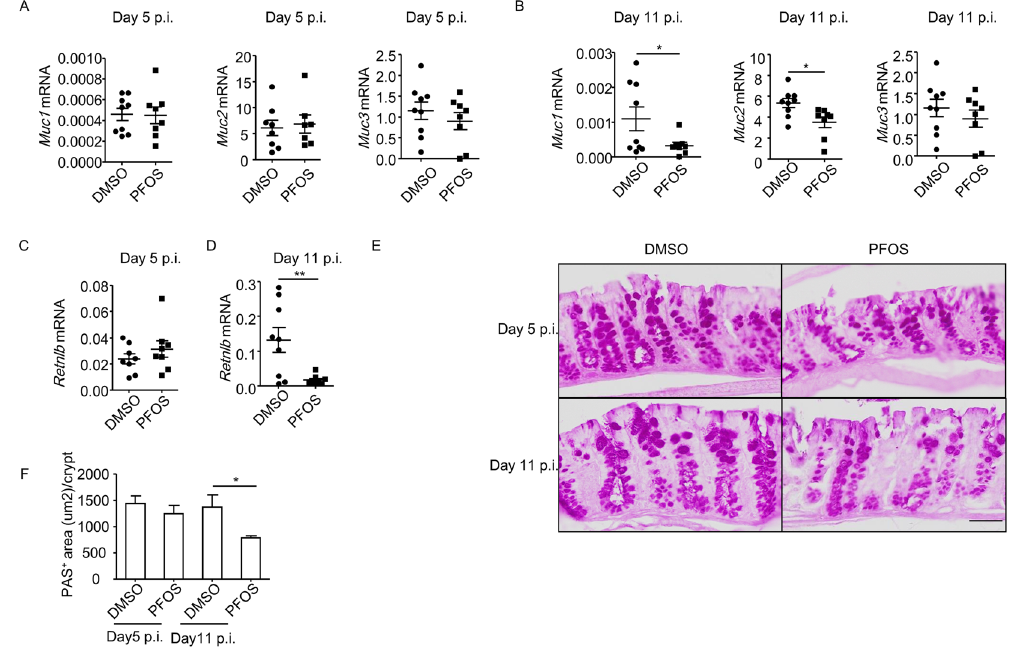
Figure 7. PFOS ablates function of goblet cells at late phase of C. rodentium infection. Wild-type mice were treated with PFOS and infected with C. rodentium as described in Fig. 1. ( A ) mRNA expression of Muc1, Muc2 and Muc3 at day 5 post C. rodentium infection in colon tissues was analyzed by realtime RT-PCR. ( B ) mRNA expression of Muc1, Muc2 and Muc3 at day 11 post C. rodentium infection in colon tissues was analyzed by realtime RT-PCR. ( C ) mRNA expression of Retnlb at day 5 post C. rodentium infection in colon tissues was analyzed by realtime RT-PCR. ( D ) mRNA expression of Retnlb at day 11 post C. rodentium infection in colon tissues was analyzed by realtime RT-PCR. ( A – D ) Horizontal lines show the mean. Error bars represent SEM. Data were pooled from two independent experiments. ( E ) Paraffin-embedded colon sections were stained with periodic acid-schiff (PAS). Magnification is 20 × (Scale bar, 50 um). ( F ) PAS + areas per crypt were quantified by ImageJ Software. Data were pooled from three mice from indicated group. Error bars represent SEM. Data are representative of two independent